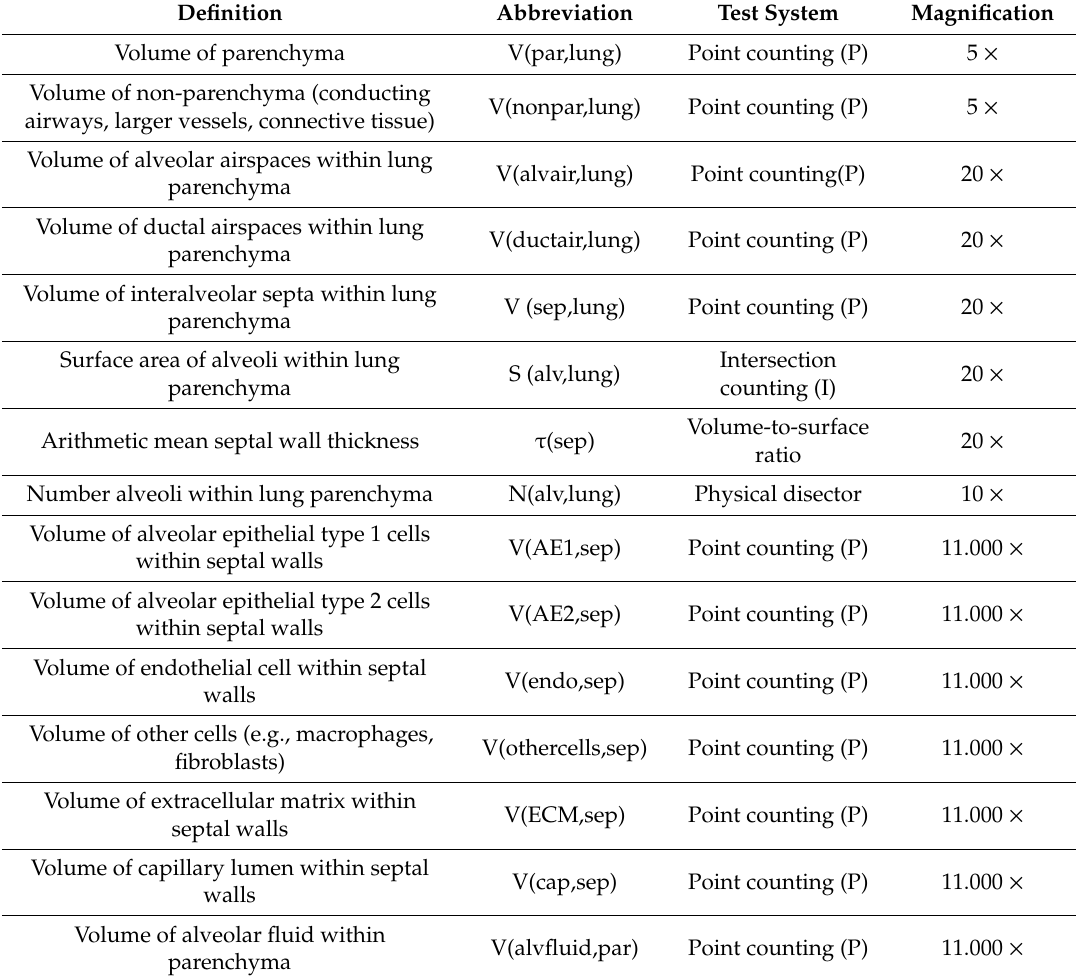
Table 5. Definition of stereological